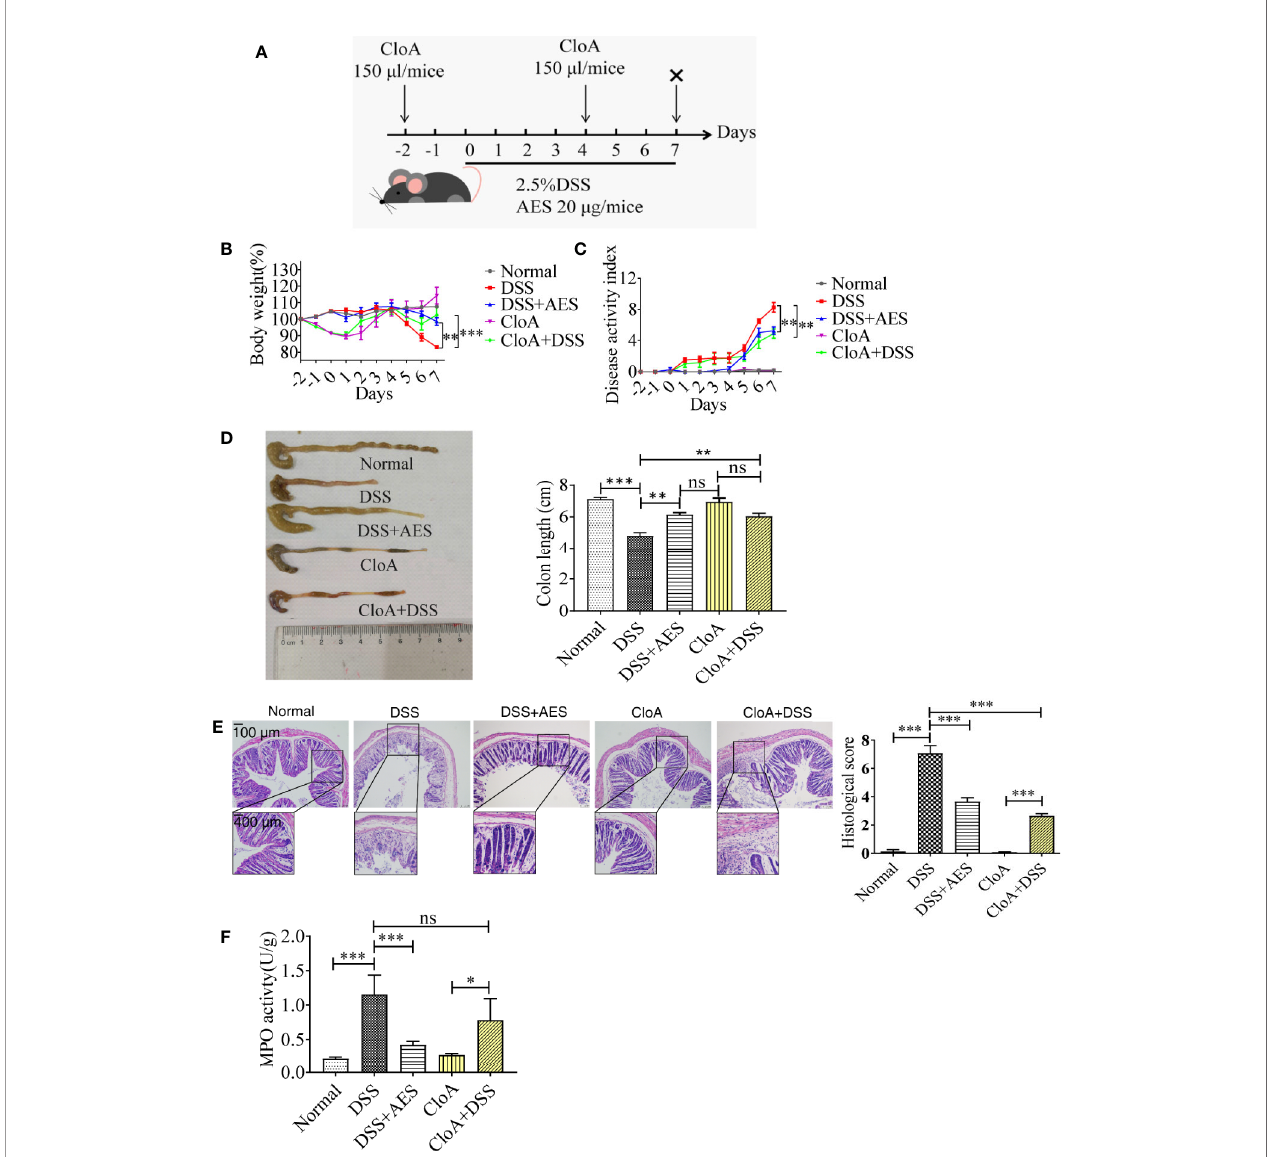
FIGURE 1 | T. spiralis AES alleviated DSS-induced colitis in mice. Mice were divided into 5 groups with 6 mice each, treated with DSS, DSS+AES, CloA, and CloA+ DSS, respectively. Another group of 6 mice were given PBS as normal control. (A) The detailed study regimen including time points for administration of DSS, T. spiralis AES, and CloA. (B) Percentage of mouse weight loss after treatment (n=6). (C) Clinical disease activity index (DAI) was assessed (n=6). (D) Representative colonic length from each group (left) and average reduction in colonic length (right) (n=6). (E) H&E staining of representative colon samples from each group (left) and the changes in histological score in each group is shown on the right (n=6). (F) Myeloperoxidase activity in mouse colons of each group (n=6). Experiments were repeated in triplicate. Data are expressed as means ± SEM. “ × ” indicates sacri fi cing of mice. *indicates signi fi cant differences between experimental groups and controls. * P < 0.05, ** P < 0.01, *** P < 0.001; ns = not signi fi